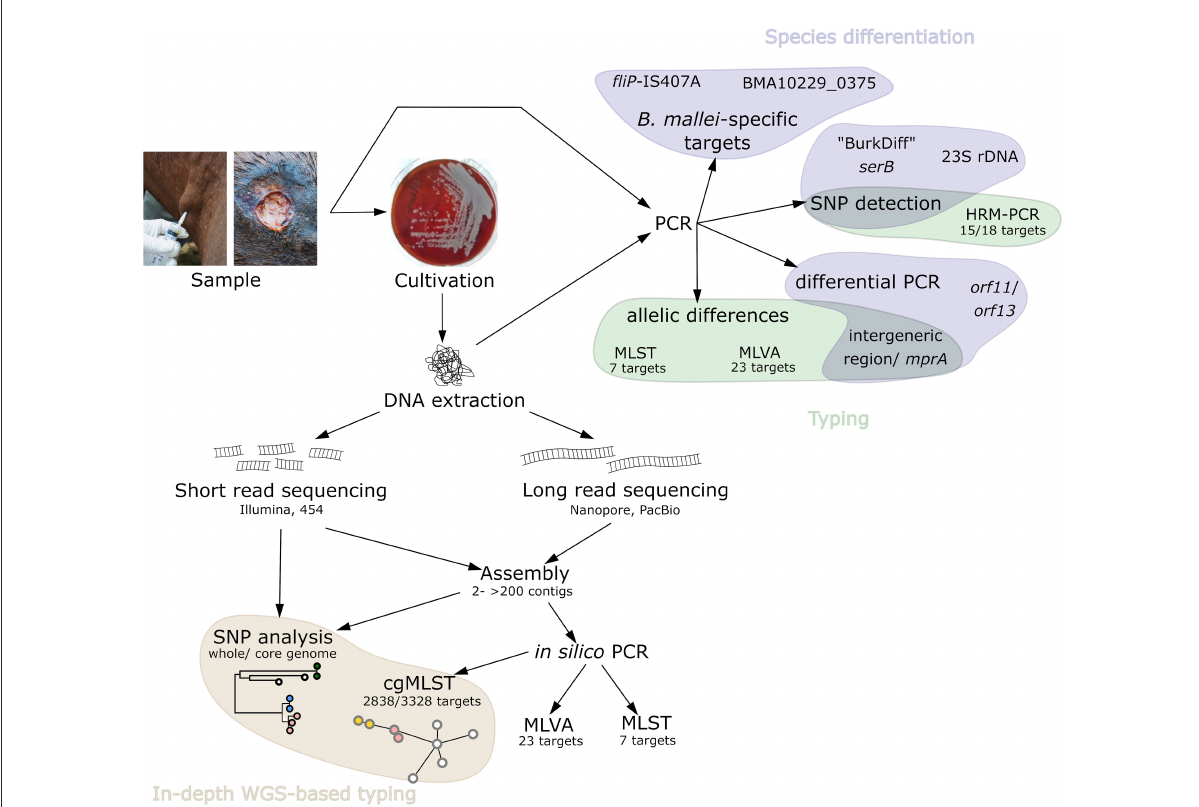
FIGURE2 Schematic overview of the available, relevant PCR-based B. mallei detection and typing methods as well as methods employing genome sequencing.